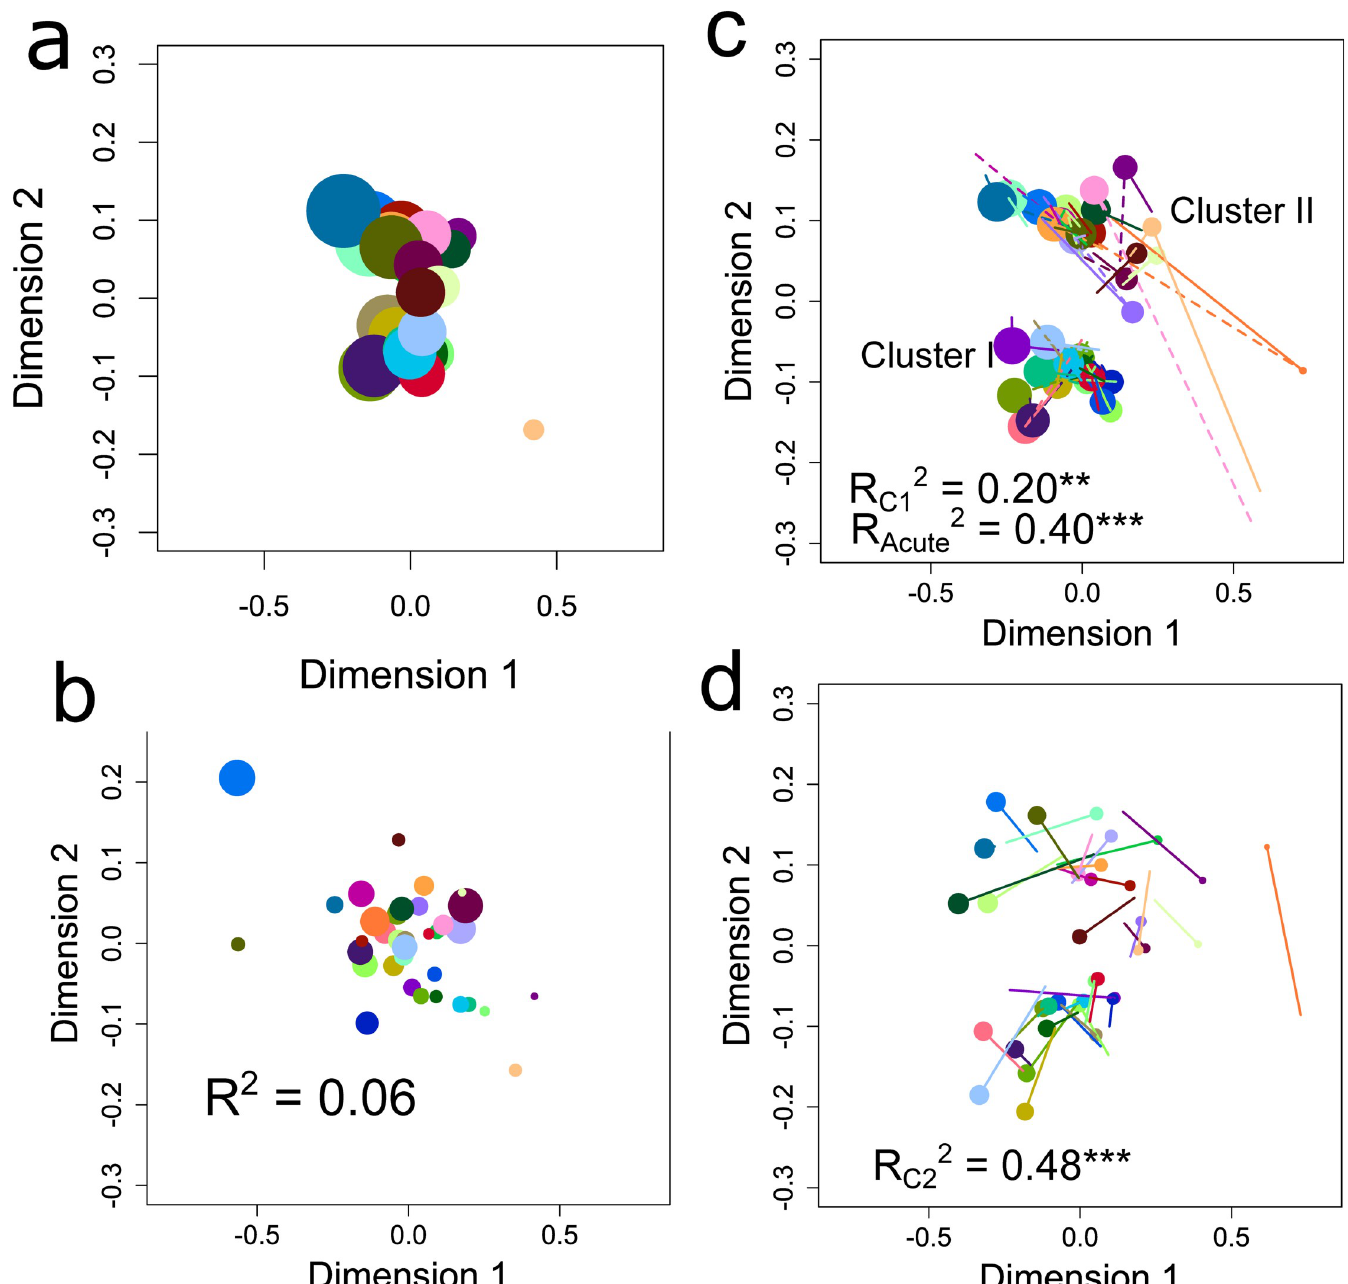
Fig 2. Antisera maps for IgG and IgM. Maps were constructed from data on a , IgG at the acute timepoint; b , IgG at timepoint C2 (the consensus antisera map); b , IgM at the acute timepoint; d , IgM at timepoint C2. In c , solid and dashed lines point to positions in the map for IgG at the acute (as in a ) and C1 timepoints, respectively. In c and d , solid lines point to positions in the consensus antisera map shown by the points in c . Symbol size is proportional to the antisera’s average log 10 OD value at the timepoint indicated. R 2 values represent goodness-of-fit to the consensus map with subscripts indicating the timepoint of the map being compared and asterisks indicating significance ( ��� , P < 0.001; �� , P <